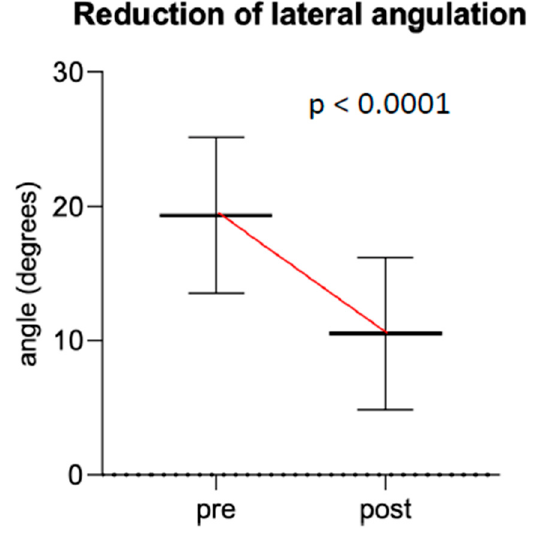
Figure 6. Change in median sagittal angulation before and after cast wedging.